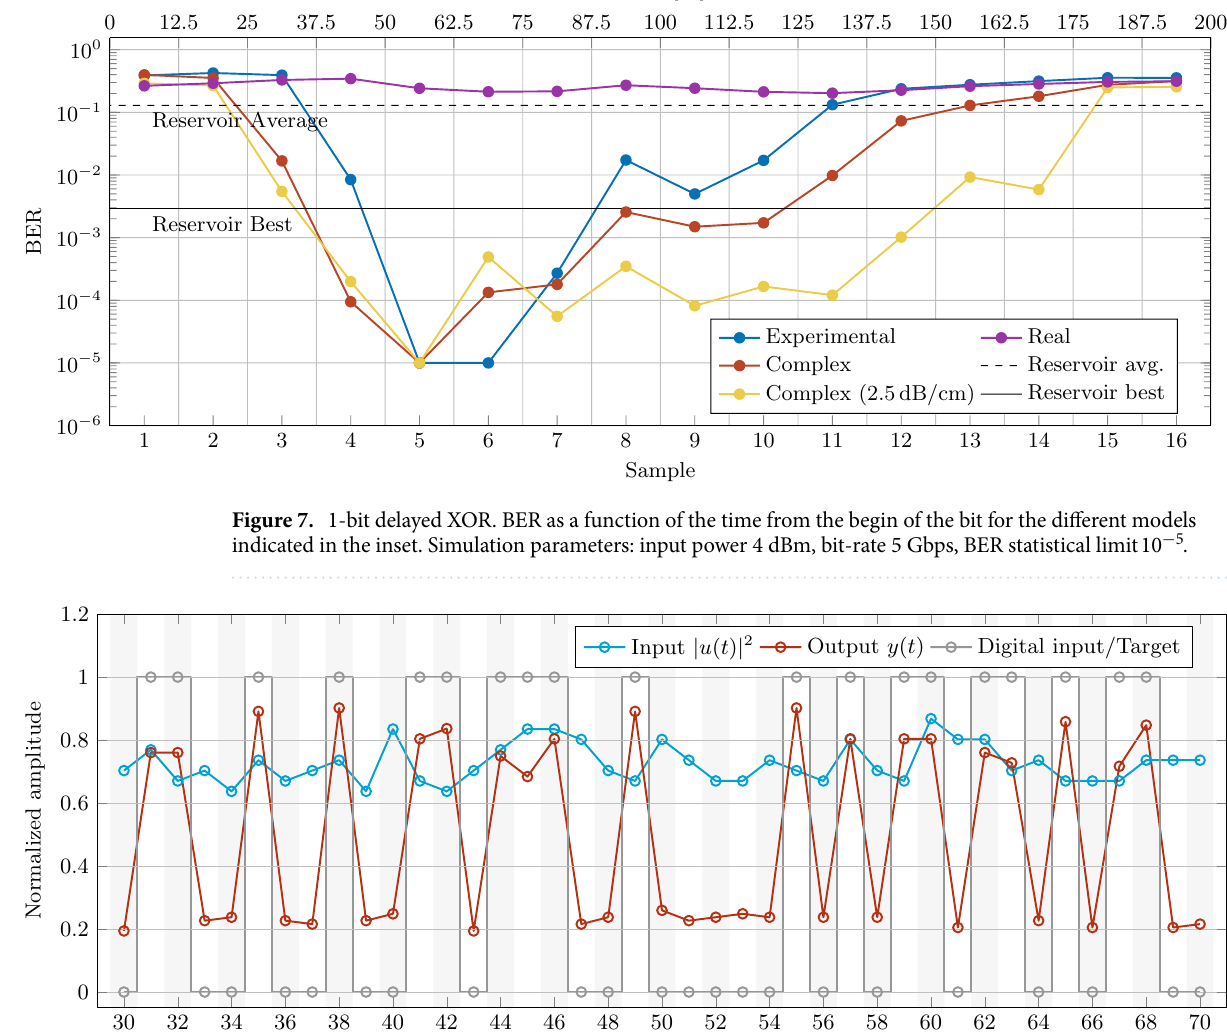
Figure 8. Input signal intensity (blue), output signal intensity (red) and digital input phase (gray) as a function of the bit